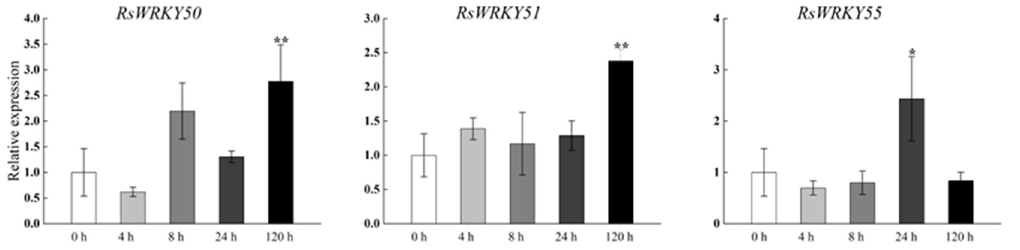
Figure 8. Expression profiles of RsWRKY genes under drought treatment. Gene expression at 0 h was normalized as “1.” Data are meant ± standard deviation (SD), calculated from three biological replicates, and vertical lines represent the standard deviation. * and ** mean significant difference at p < 0.05 and p < 0.01, respectively.